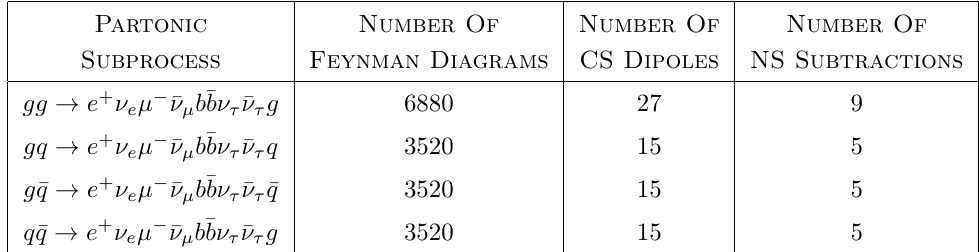
( (cid:11) 3 (cid:11) 6 ) s O